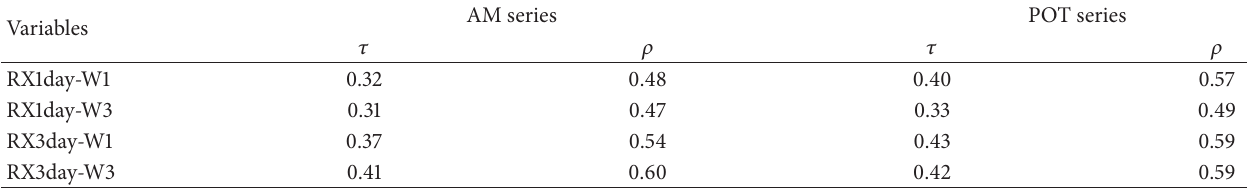
Table 4: Correlation coefficient of the different extreme samples.